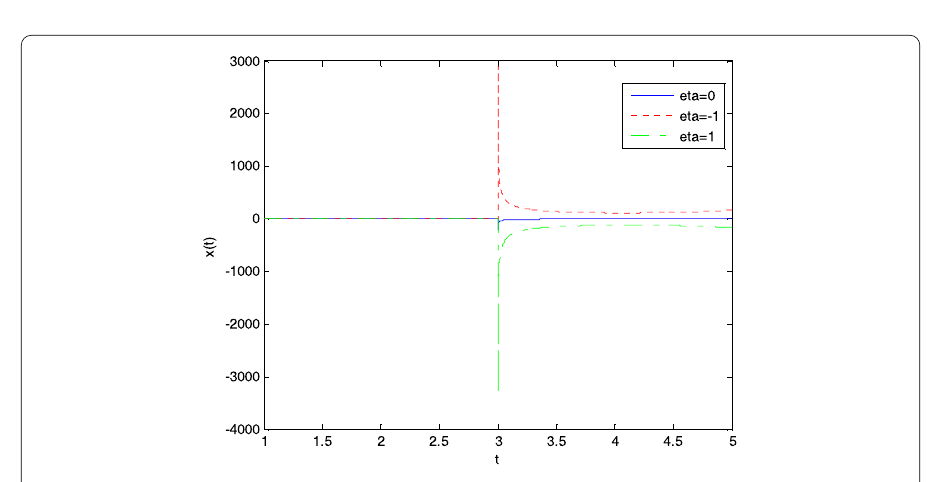
Figure 8 The solution trajectory of system (5.2) with ρ =